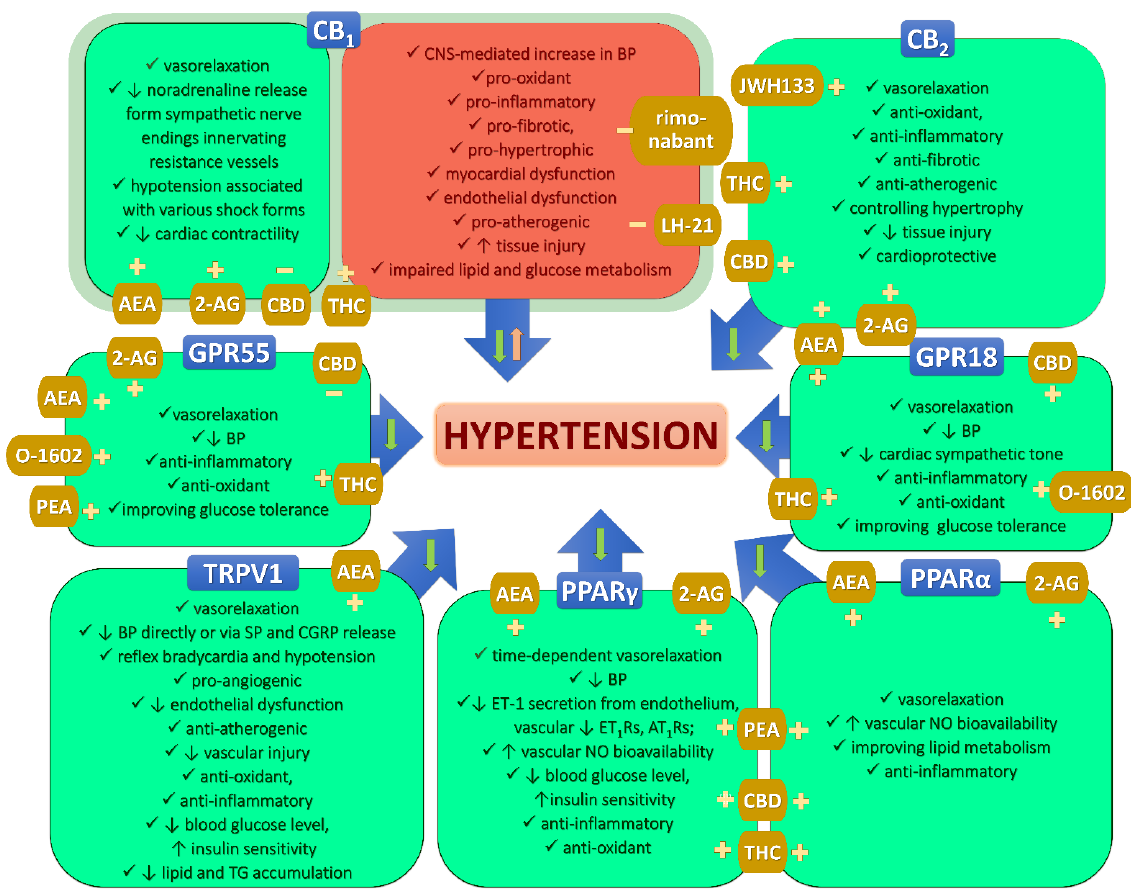
Figure 1. Well-known potential effects (not only related to the cardiovascular system) of compounds described in tables after interacting with classical and non-classical cannabinoid receptors. For receptor affinity, see [74–78]. For references regarding effects of particular receptors, see Section 6. Green indicates pro-hypotensive and red pro-hypertensive effects. Arrows next to effects indicate increase ( ↑ ) or decrease ( ↓ ); arrows in the center indicate predominantly pro-hypotensive ( ↓ ) or hypertensive ( ↑ ) effects. (+) activation, ( − ) blockade. 2-AG—2-arachidonoyl glycerol; AEA—